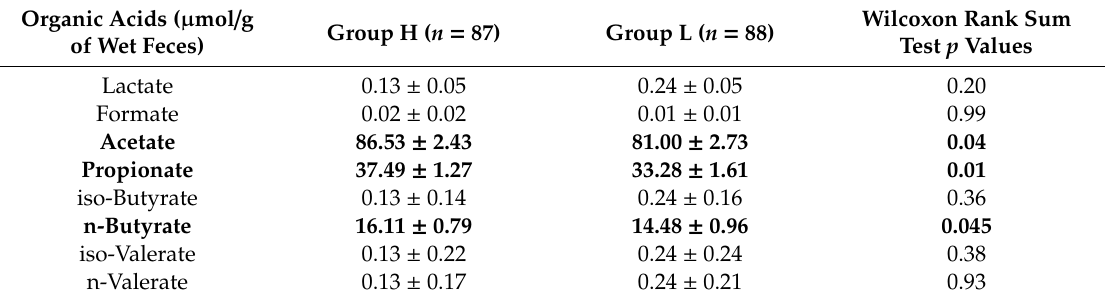
Table4. Organicacidconcentrationsinfecalsamplesofhigh-andlow-reproductiveperformancegroups. Organic Acids ( µ mol / g